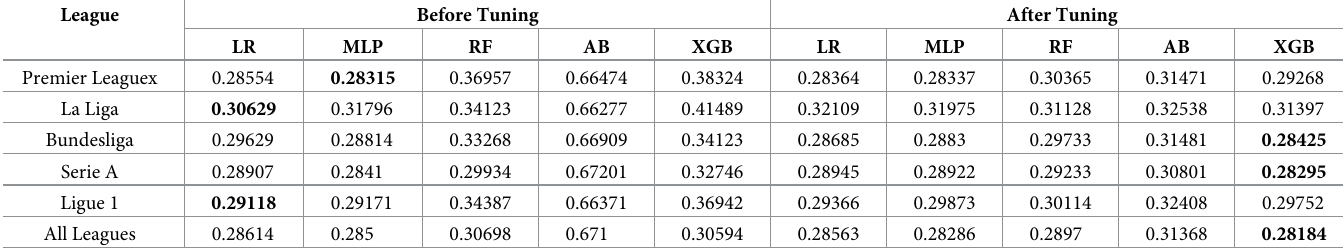
Table 2. Log loss test set scores for each league and model, before and after tuning (LR = logisitic regression, RF = random forest, AB = AdaBoost, XGB = XGBoost). The best score for each league is highlighted in bold. League Before Tuning After